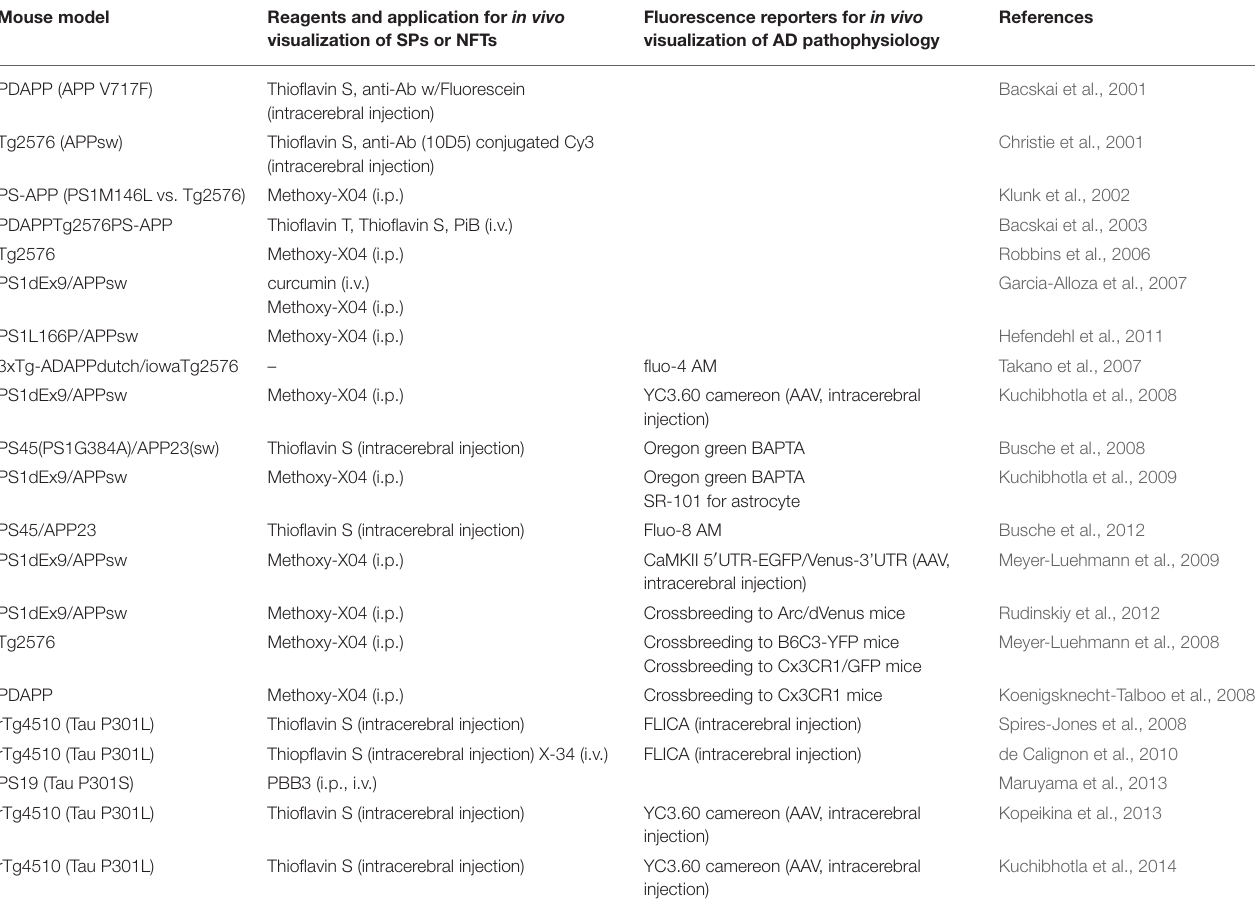
TABLE 2 | Reference list for in vivo fluorescence imaging in living mouse